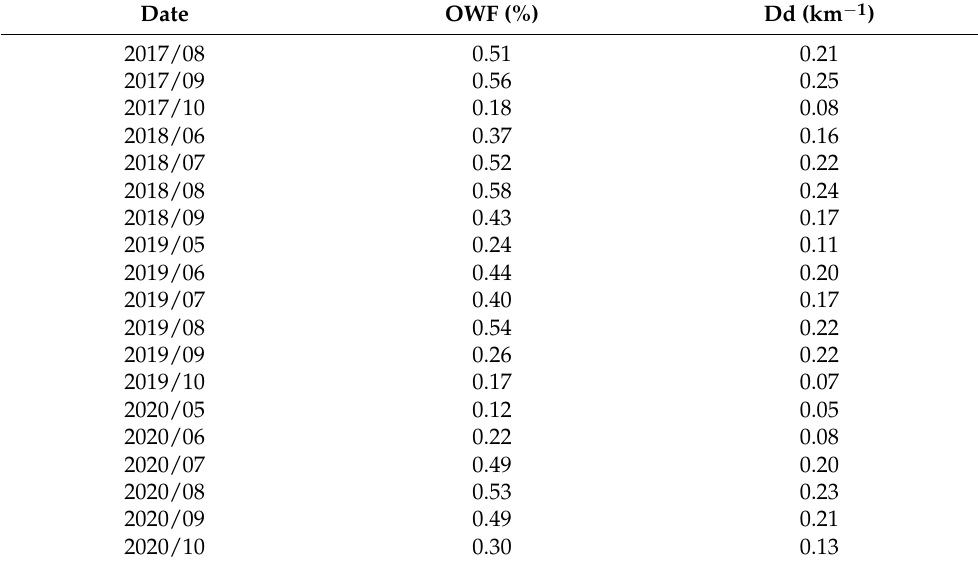
Figure 15. Spatial distribution of river networks. ( a ) River mask; ( b ) Elevation of river pixels; ( c ) Distance from water pixels to pour point; ( d ) Slope of river pixels. Table 4. Statistics of OWF, Dd of river